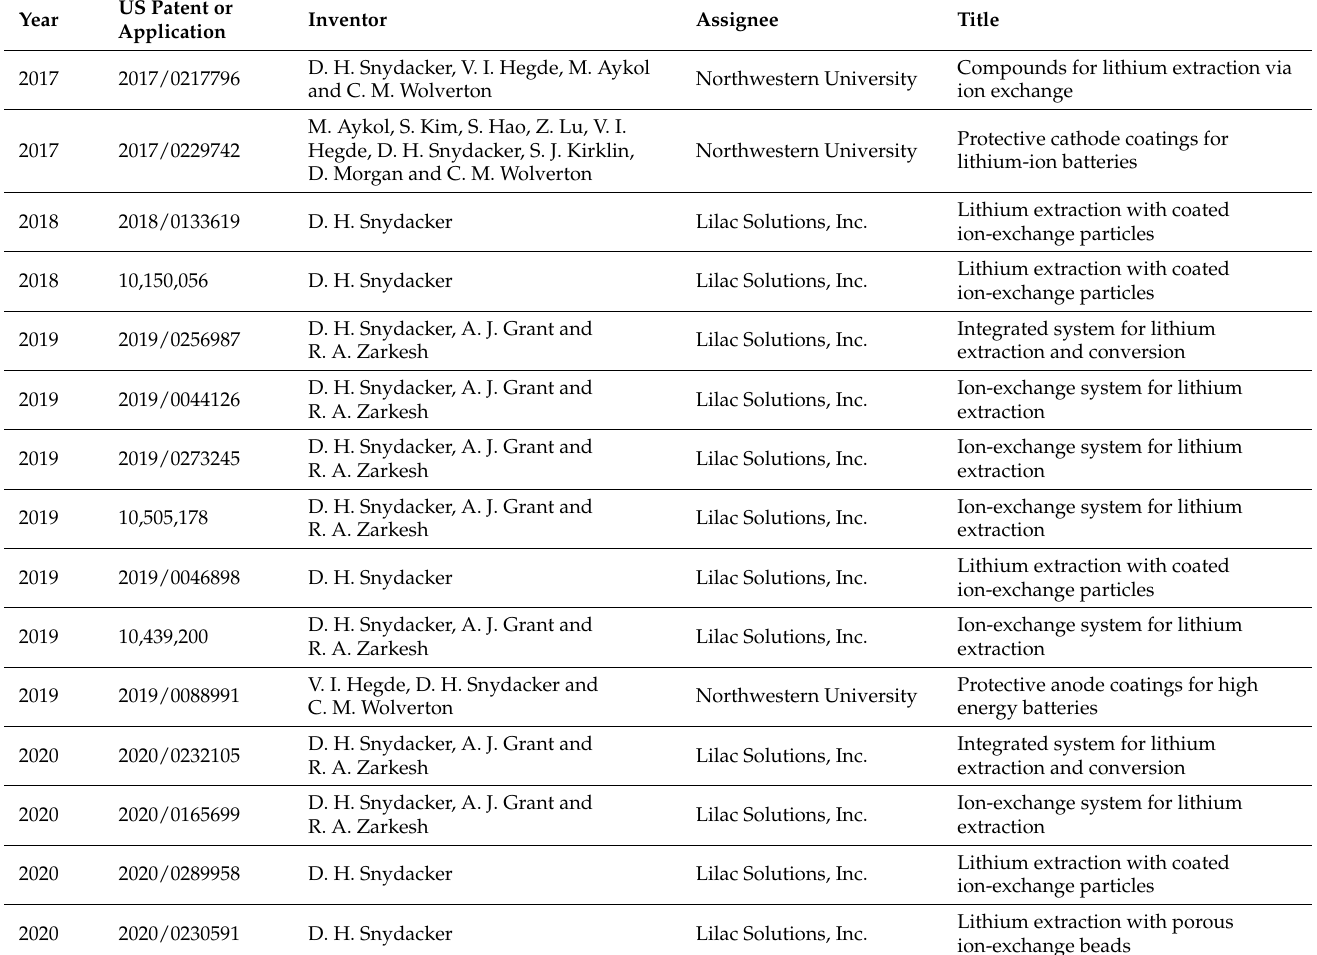
Table 11. Patents associated with Lilac Solutions or D. H.